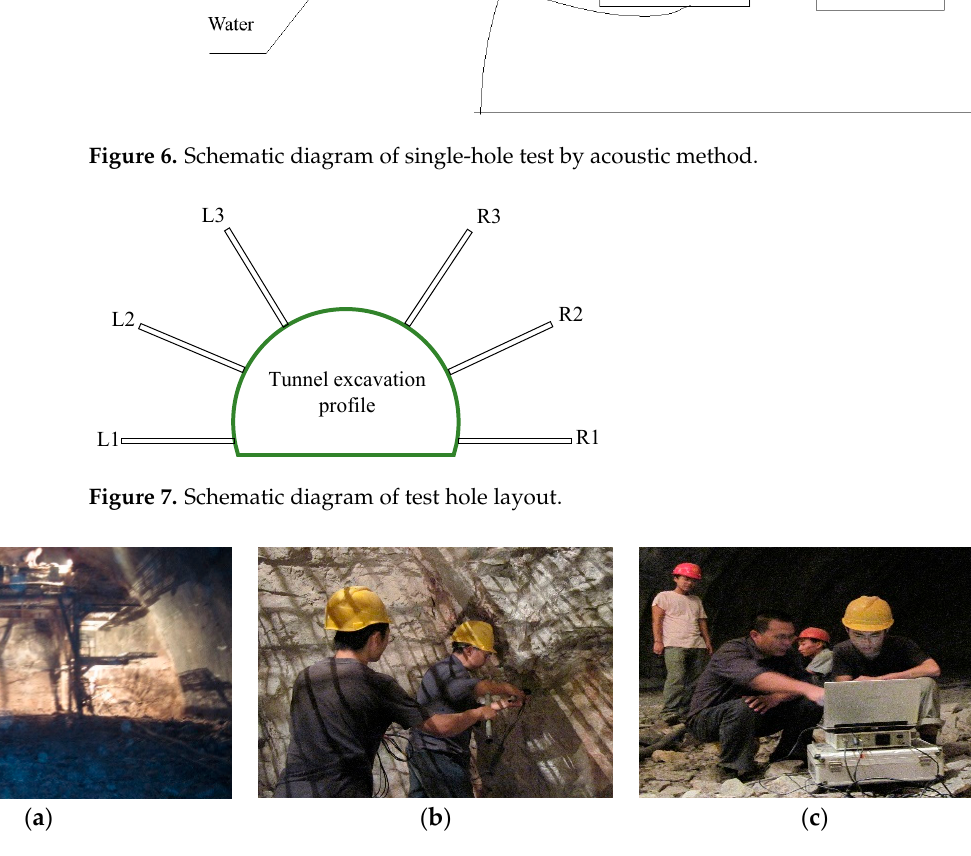
Figure 8. Field test of the loose circle. ( a ) Use support trolley to assist drilling; ( b ) install monitoring sensors; ( c ) observe the monitoring results.